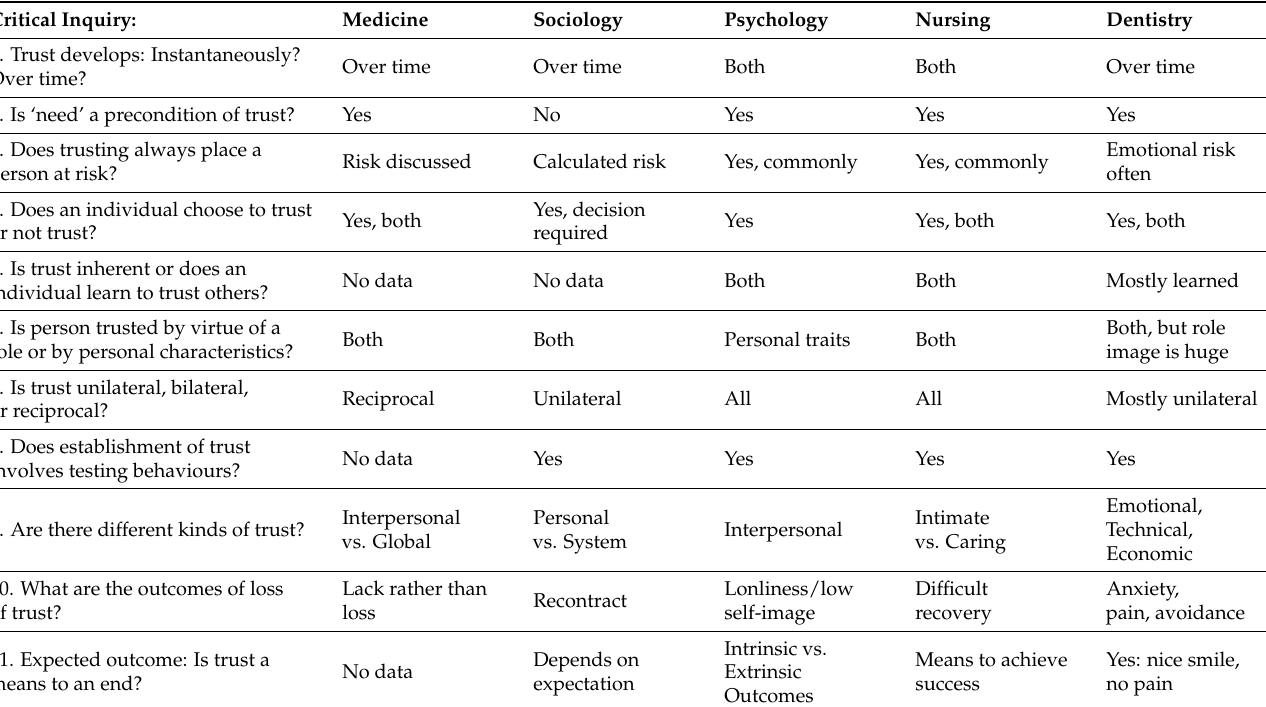
Table 1. Critical inquiries of trusting concepts in four professions compared with dentistry—a